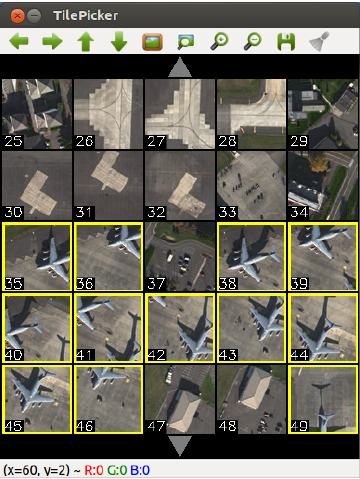
Figure 4: “TilePicker” GUI used to quickly curate detections as part of the bootstrapping